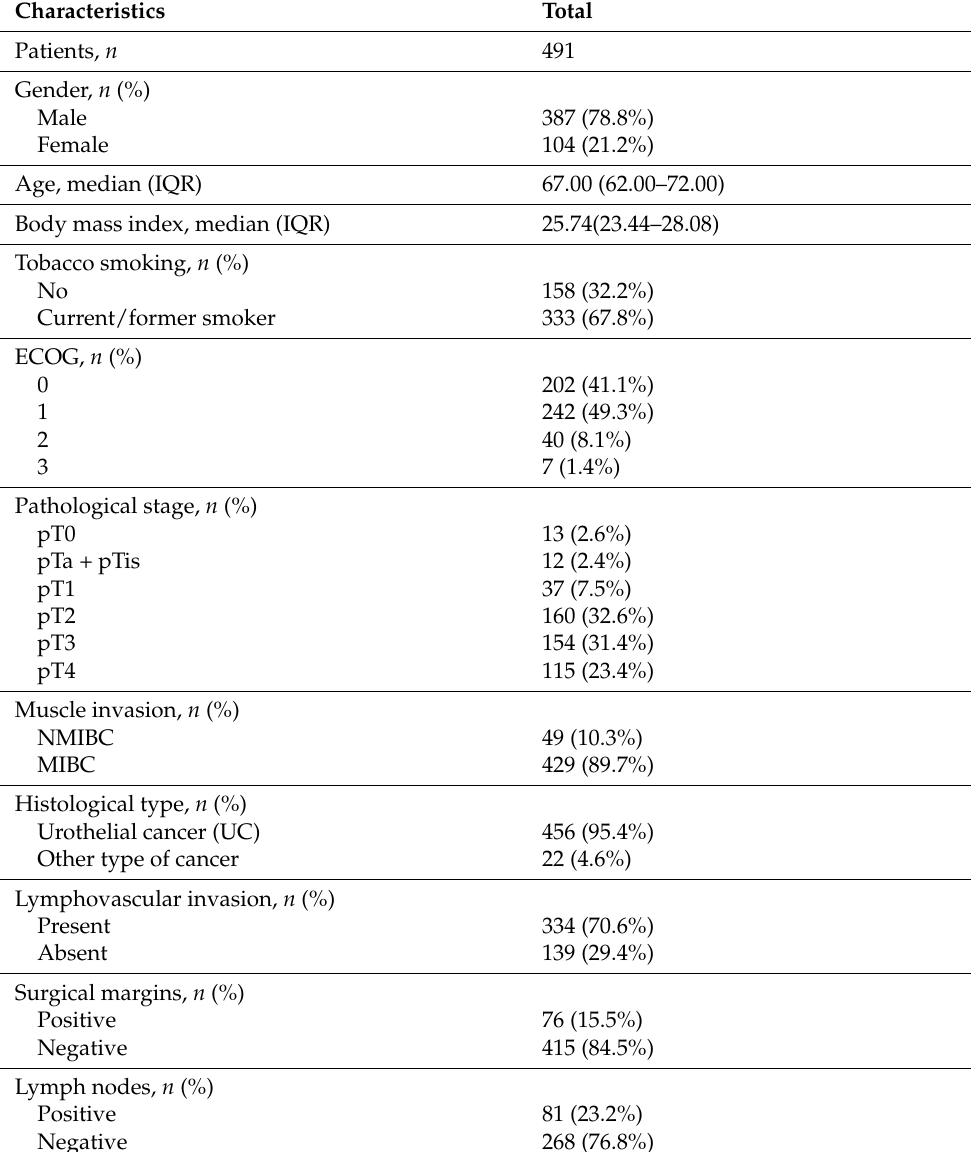
Table 1. Demographic, clinical, and histopathological characteristics of